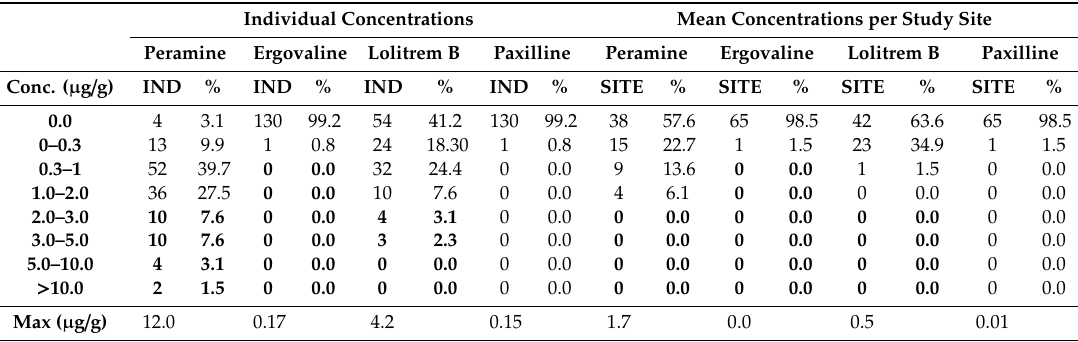
Table 2. Number of individuals (IND, only infected Lolium perenne ) or study sites (SITE, infected and not infected Lolium perenne ) within alkaloid concentration range [ µ g / g DW] of peramine, ergovaline, lolitrem B, and paxilline and their relative proportion of all individuals, or all study sites. Max: maximum of alkaloid concentrations. Individuals or study sites that show concentrations above toxicity thresholds are marked in bold. Individuals: n = 131, study sites: n =